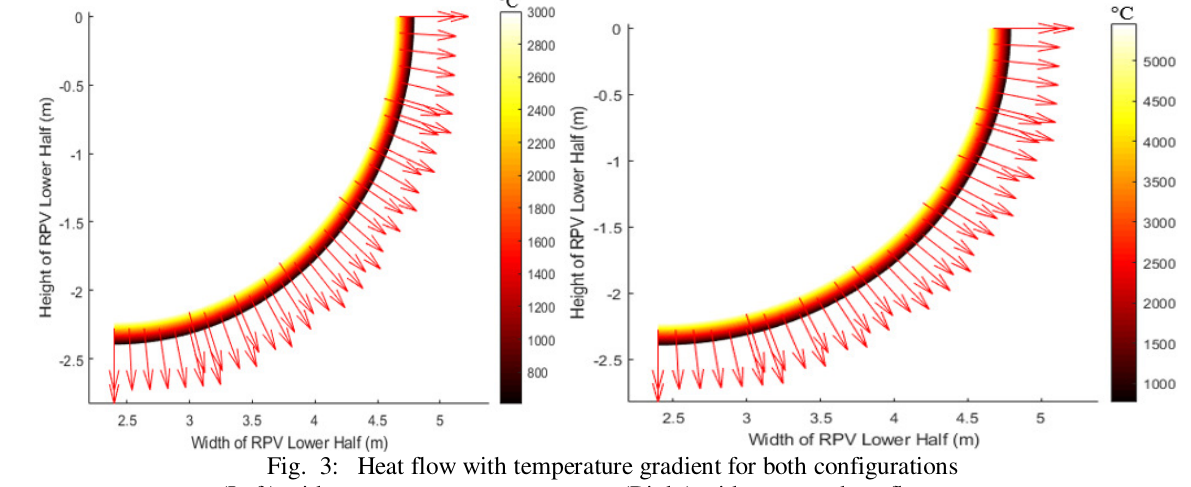
Fig. 3: Heat flow with temperature gradient for both configurations (Left) with constant temperature source (Right) with constant heat flux